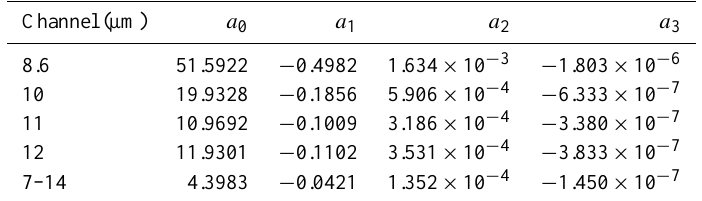
Table 3. Polynomial fit coefficients for computing NE 1T as a function of scene temperature and channel.